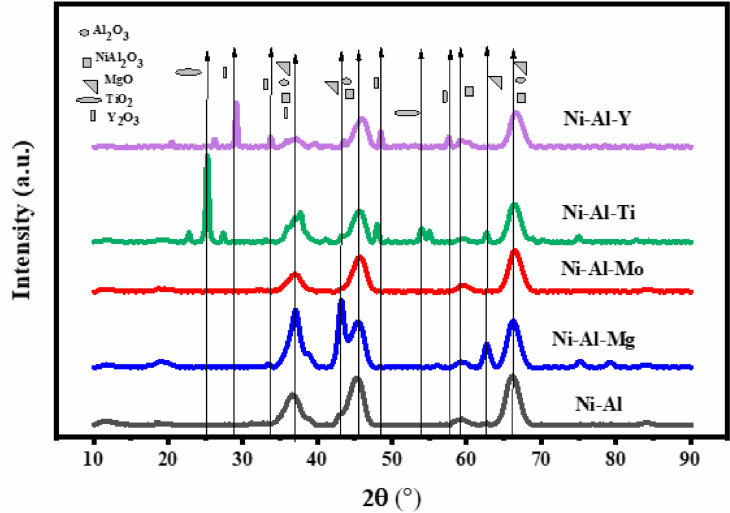
Figure 1. The XRD profiles of Ni-Al-x (x = 0, Mo, Ti, Y, and Mg)